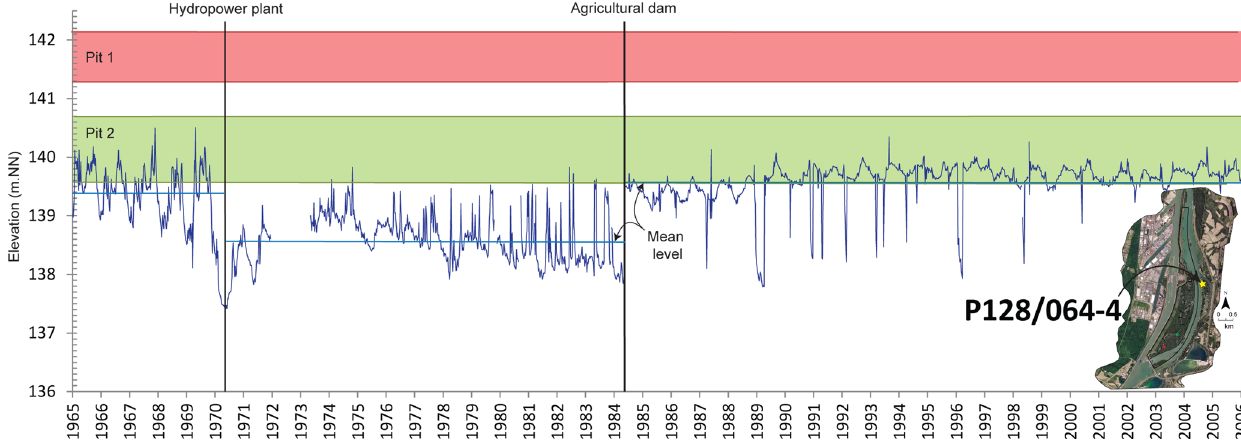
Figure 8. Hydrogeological variation between 1965 and 2006. After 1984, the lowest peaks correspond to periods during which the Old Rhine is